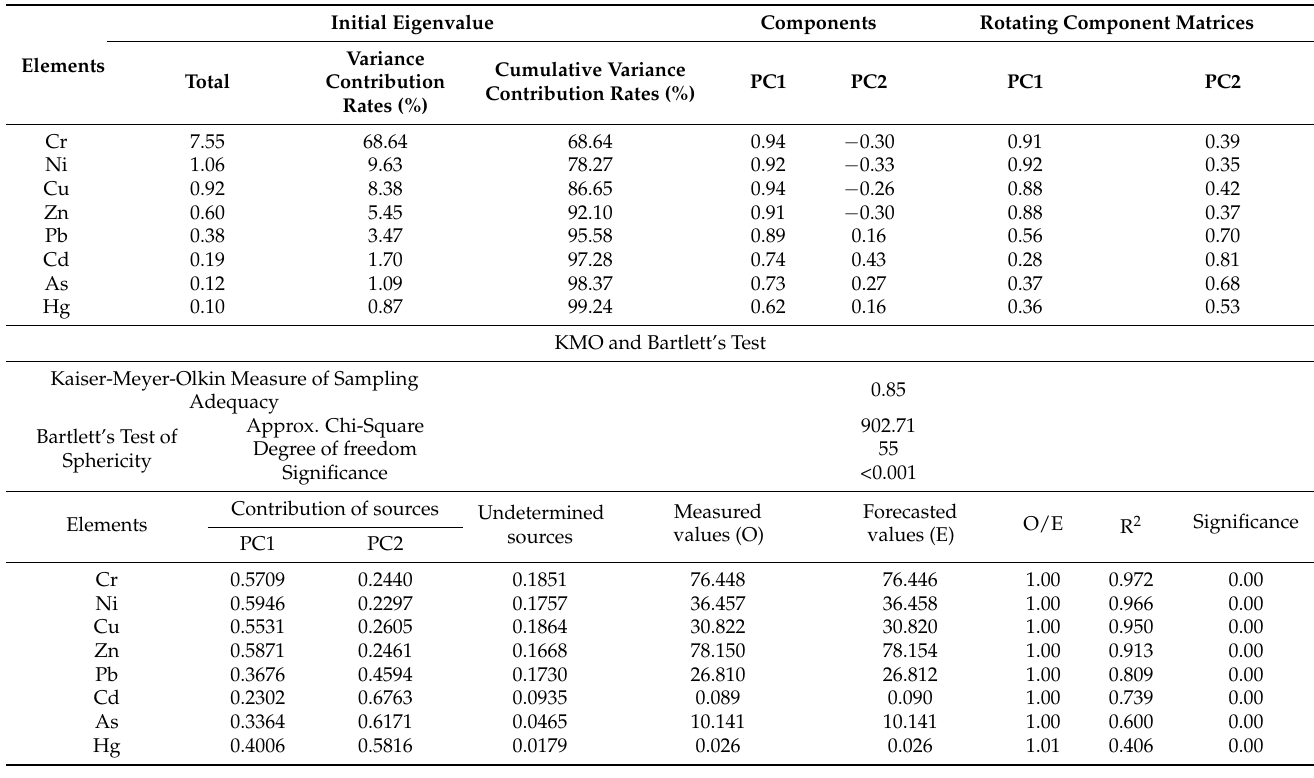
Table 3. Total variance of interpretation and rotating component matrix in the APCS–MLR model with metal sources in the lake